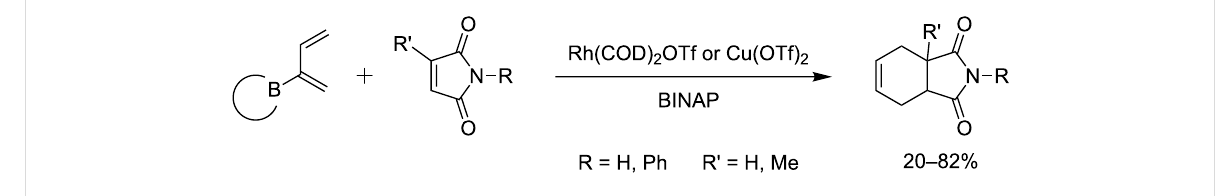
Scheme 15: Metal catalyzed tandem Diels–Alder/hydrolysis